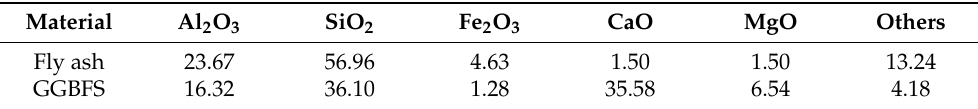
Table 2. Chemical composition of FA and GGBFS